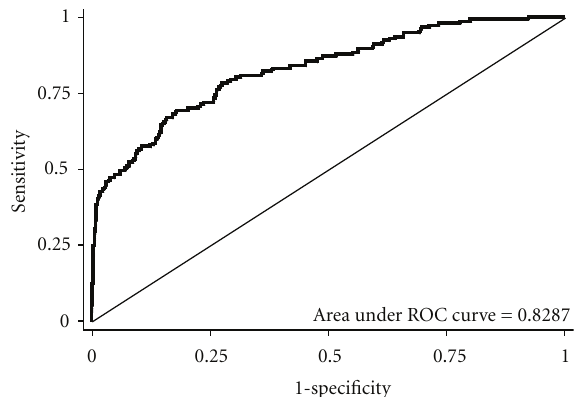
Figure 2: Receiver operating characteristic curve of the microarray for 91 anal swab samples tested for 102 HPV